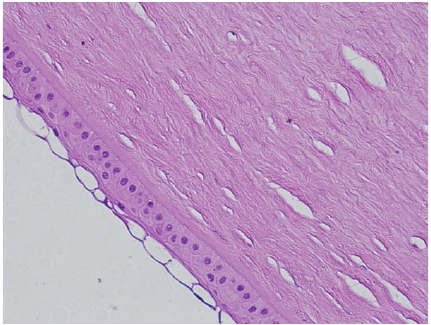
Figure 2: The image of the same corneal specimen at high magnifi- cation ( × 400). The thin-walled cystic vesicles are seen on the outer (epithelial) surface of the cornea. 180 × 135mm (300 × 300